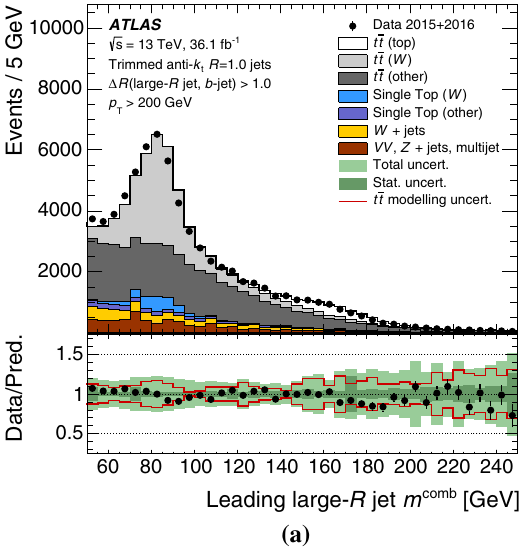
described in Sect. 4.2. The statistical uncertainty of the background pre- diction (Stat. uncert.) results from limited Monte Carlo statistics as well as the limited size of the data sample used in the data-driven estimation of the multijet background